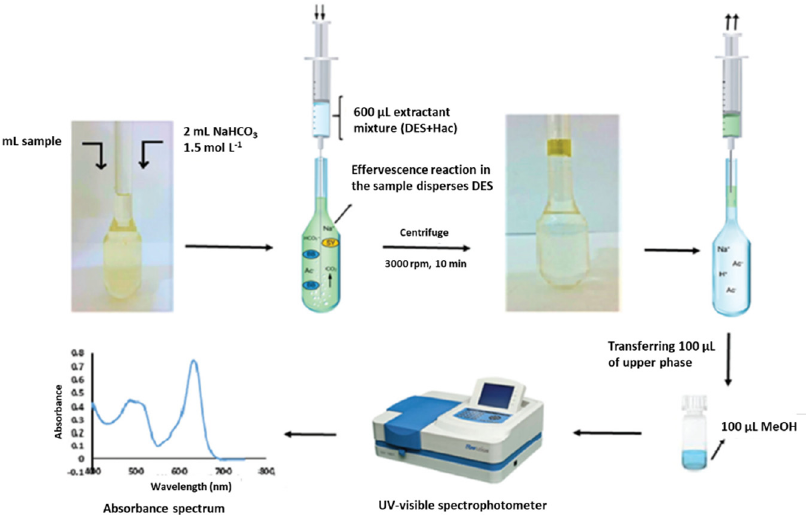
Figure 2. Schematic diagram of effervescence assisted dispersive liquid–liquid microextraction. Reprinted from Ravandi and Fat’hi [117] with permission of Royal Society of Chemistry.